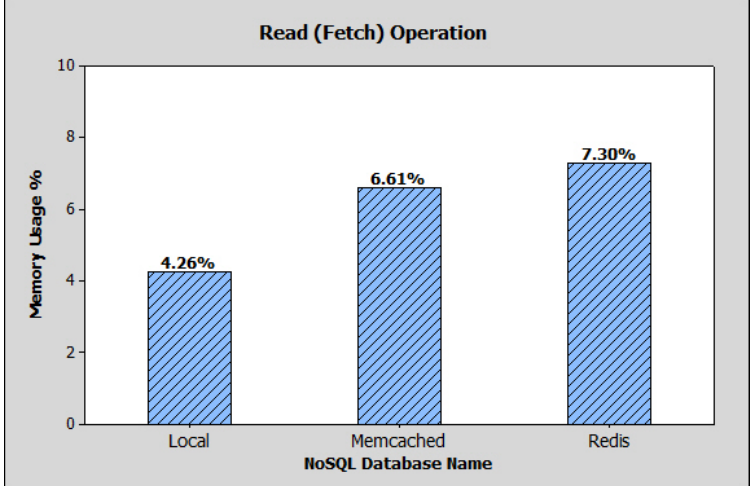
Figure 2. Memory usage with read operation (Single Client).